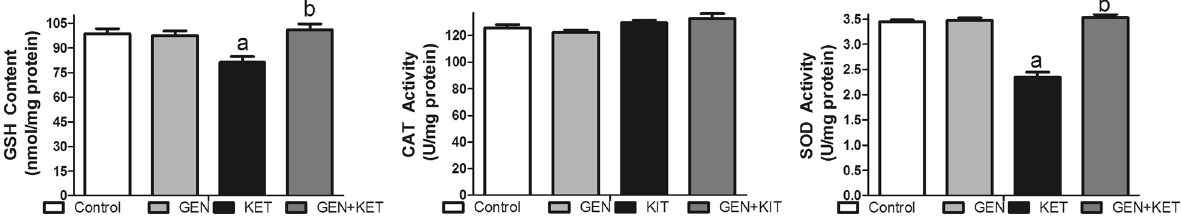
Fig. 3 Effect of GEN on hepatic GSH content and CAT and SOD activities in control and KET-treated rats. Each column represents the mean for six rats in each group. Significance was determined by one-way analysis of variance followed by Dunnett’s t test: a P < 0.05 versus control group; b P < 0.05 versus KET